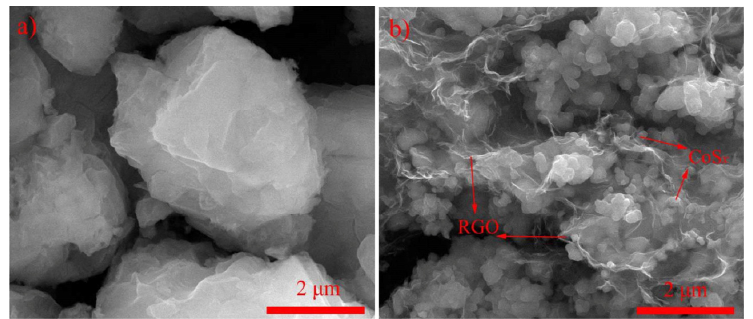
Figure 9. SEM images of ( a ) CoS x ; ( b ) CoS x /RGO. Reproduced with permission from Junsheng Zhu, Embedding cobalt sulfide in reduced graphene oxide for superior lithium-ion storage; published by Elsevier, 2019 [82].